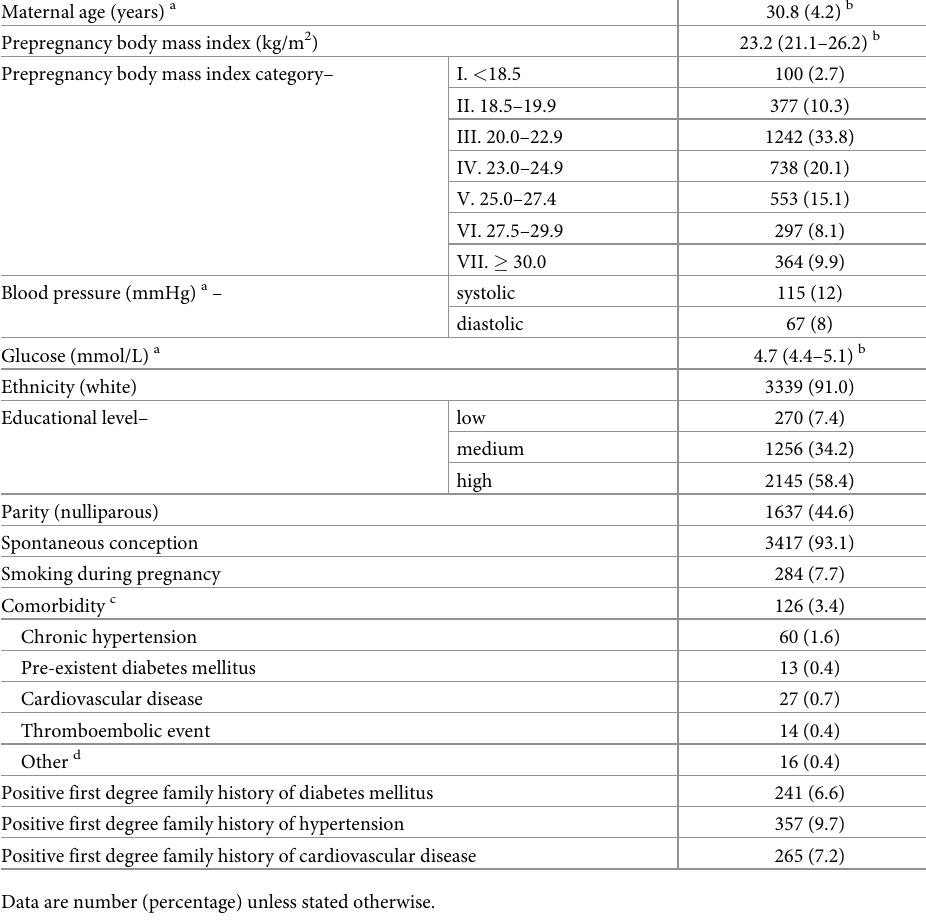
Table 1. Characteristics of the study population (n =